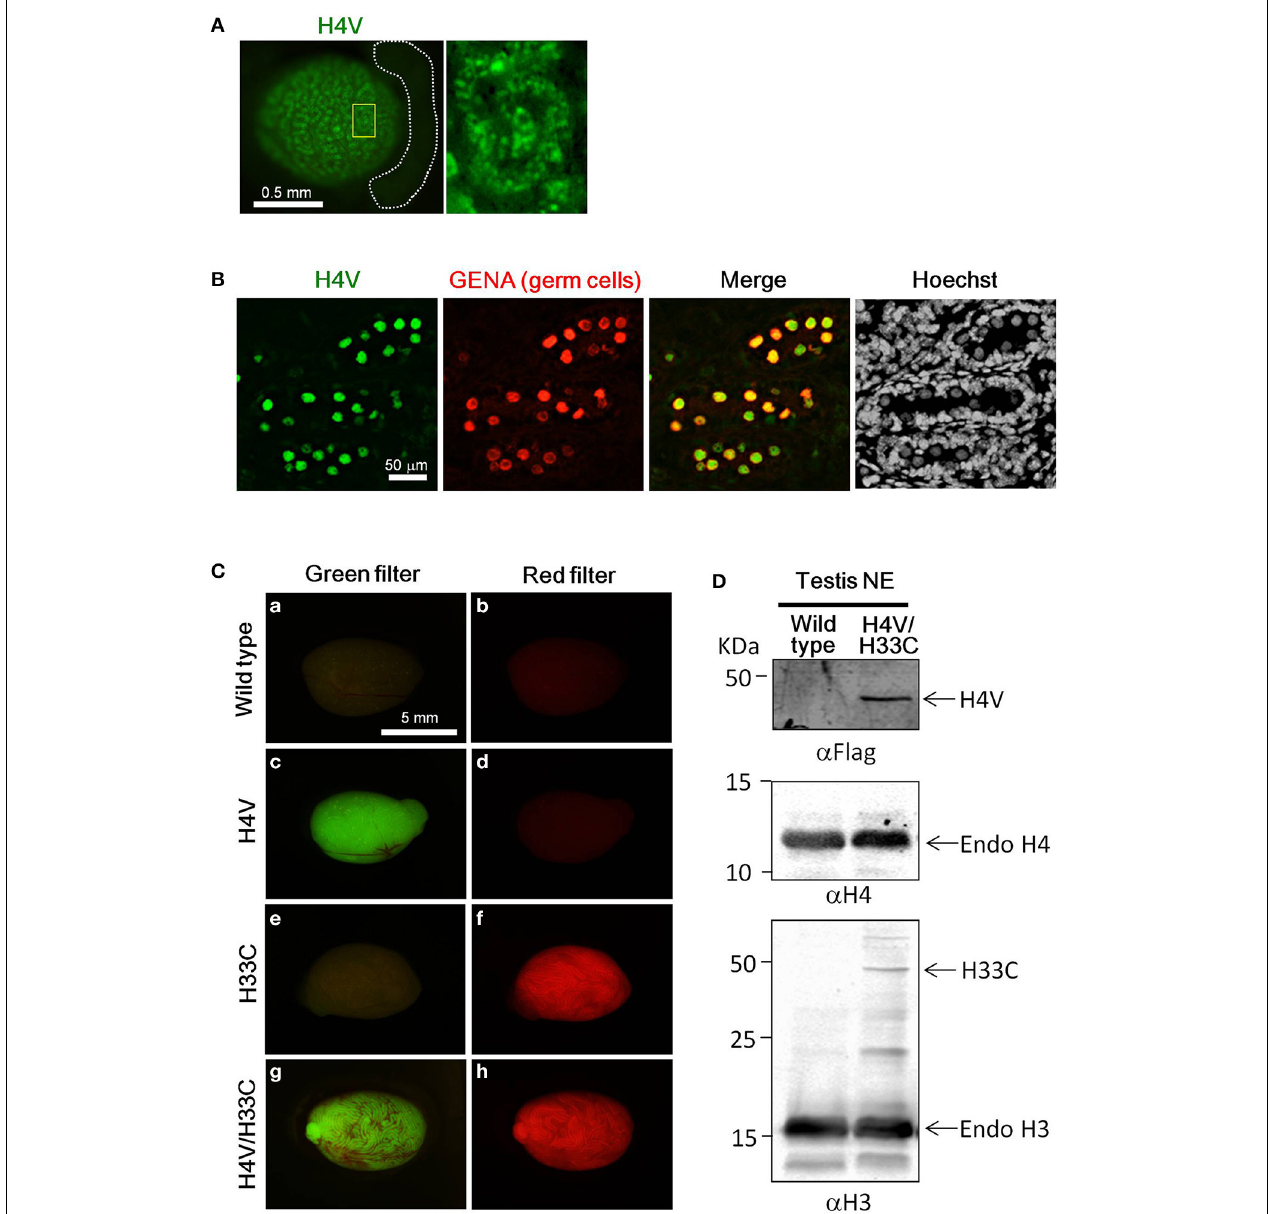
FIGURE 2 | Expression of H4V and H33C in mouse testes. (A) Gross view of P0.5 testis of H4V Tg mouse (left panel). White dotted lines indicate the epididymis. Dotted distribution of H4V-positive cells is exhibited under higher magnification of an area surrounded by yellow line in the left panel (right panel). (B) Histological features of P0.5 H4V Tg testis. H4V expression was derived from the transgene (green), whereas GENA, a marker of germ cells (red), was visualized by immunostaining. (C) Gross view of adult testes of